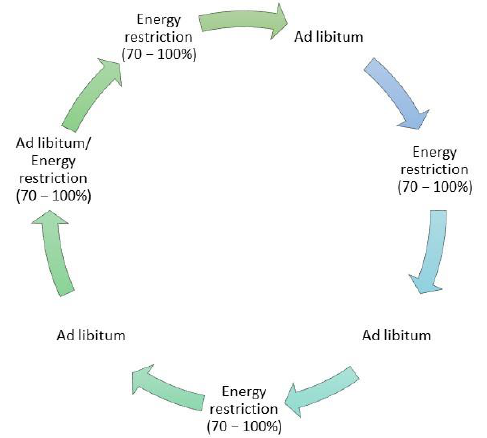
Figure 1. Exemplary scheme of alternate-day fasting (ADF) diet.